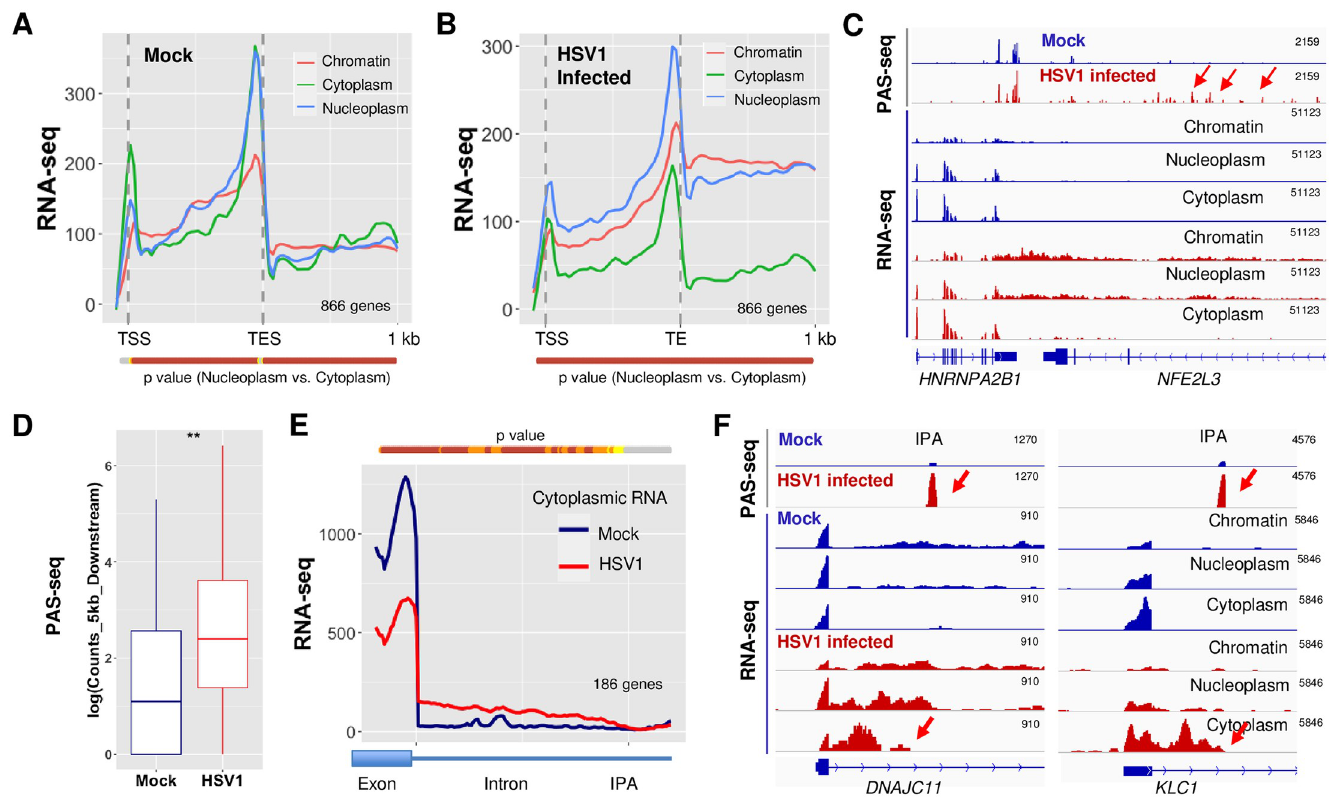
Fig 5. HSV-1-mediated APA regulation and mRNA export. Average RNA-seq signals for genes that display significant HSV-1-induced APA changes in chromatin, nucleoplasm, and cytoplasm fractions in mock-infected (A) or HSV-1-infected human fibroblast cells (B). P values for the difference in RNA-seq signals at each position between the nuclear and cytoplasmic fractions were calculated using Wilcoxon rank sum test and plotted as a color-coded bar below the plot. The color scheme is the same as Fig 2A. (C) PAS-seq and RNA-seq tracks for HNRNPA2B1 gene. Red arrow points to the PAS-seq signals downstream of the normal TES. (D) PAS-seq signals in the 5kb region downstream of the normal TES in mock- and HSV-1-infected cells. �� :P value < 0.05, Wilcox test. (E) Cytoplasmic RNA-seq signals for HSV-1-induced DtoP_intron APA changes. IPA: intronic poly(A) site. (F) PAS-seq and RNA-seq tracks for two example genes. Red arrows point to the